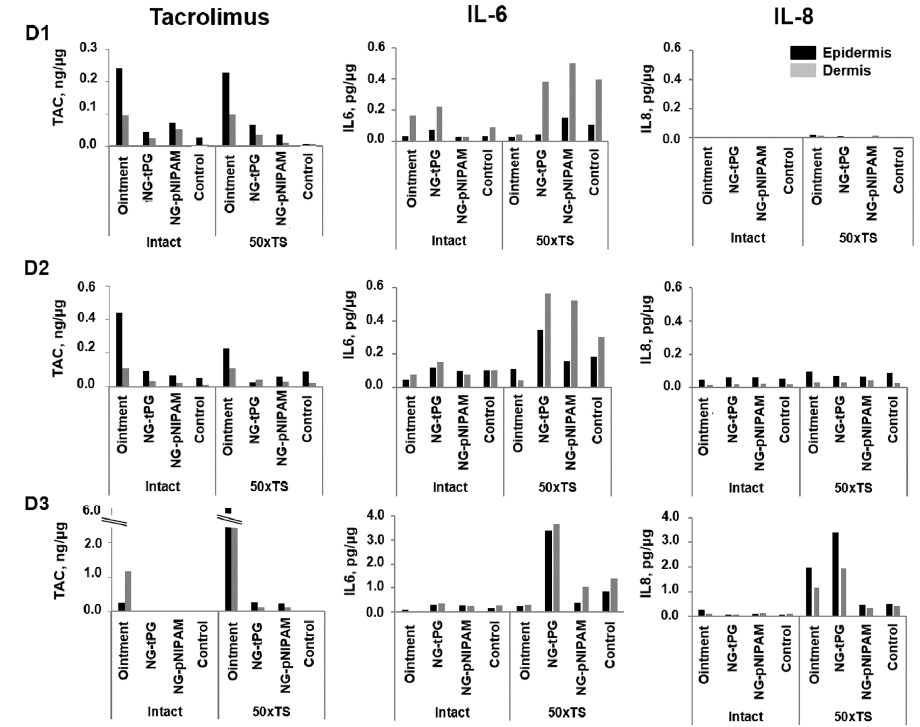
Figure A1. Tacrolimus penetration after topical application on abdominal skin with or without barrier disruption. Abdominal skin from three different donors (D1-3) was left intact or treated with tape stripping times (50 × TS). NG-pNIPAM (0.9 wt.% tacrolimus), NG-tPG (2.5 wt.% tacrolimus), and 0.1% tacrolimus ointment were applied for 24 h at a final tacrolimus concentration of 5 µg/cm 2 . Tacrolimus as well as the inflammatory markers IL-6 and IL-8 were detected in skin extracts. TAC: tacrolimus.